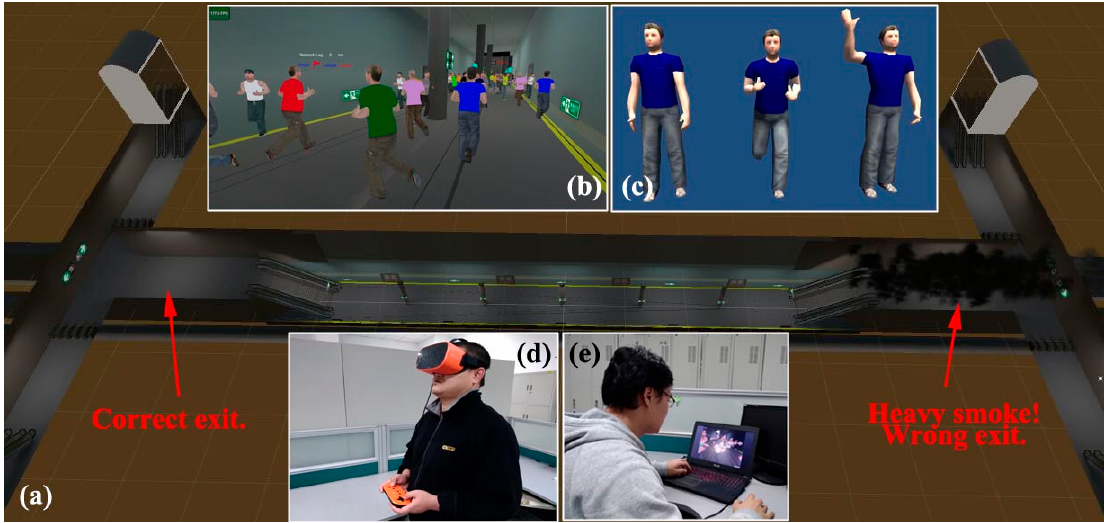
Figure 6. Prototype system overview: ( a ) subway scene with heavy smoke and dim lighting; ( b ) first person view with GUI; ( c ) three skeletal animations of an avatar; ( d ) all-in-one virtual reality (VR) client; ( e ) personal computer (PC) client.